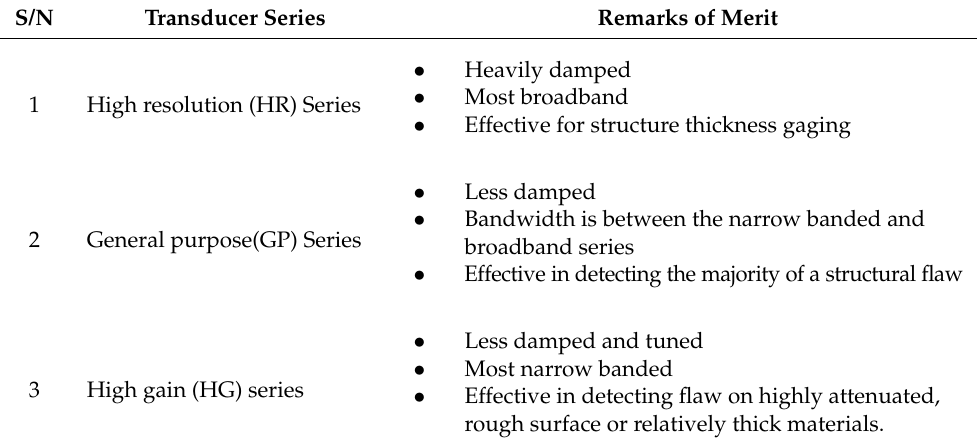
Table 2. Transducer categories concerning spectrum response.